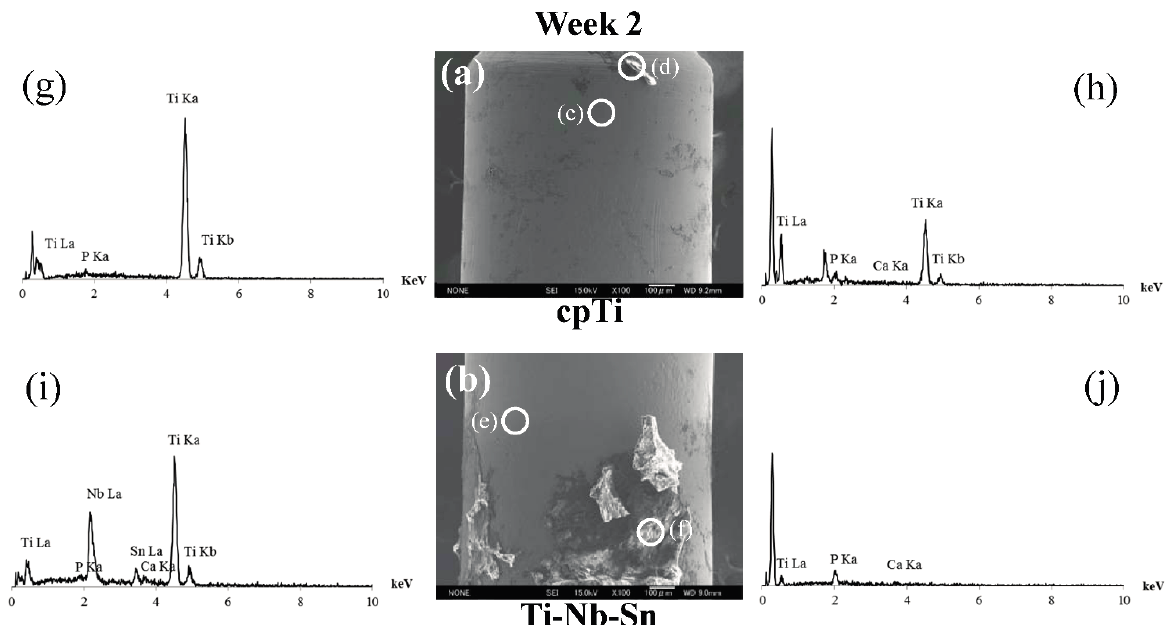
Figure 6. SEM micrographs and EDX spectra of excised implant after push-in tests. ( a ) cpTi; ( b ) Ti-Nb-Sn alloy are SEM micrographs at healing period week 2; ( g – j )